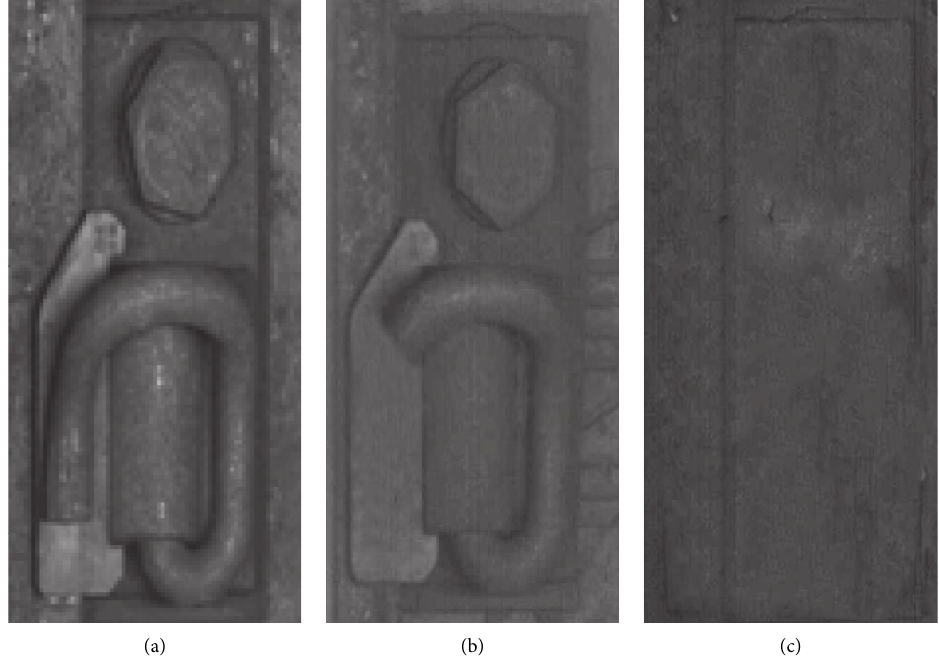
Figure 5: Samples of true fasteners. (a) Intactness, (b) fracture, and (c)